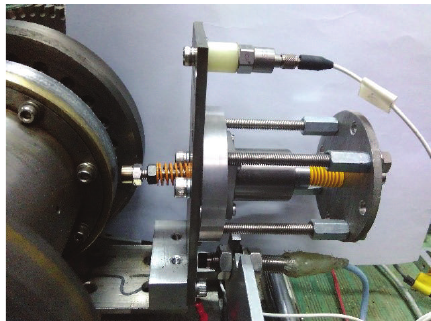
Figure 10: The rubbing diagram of dual-rotor system.